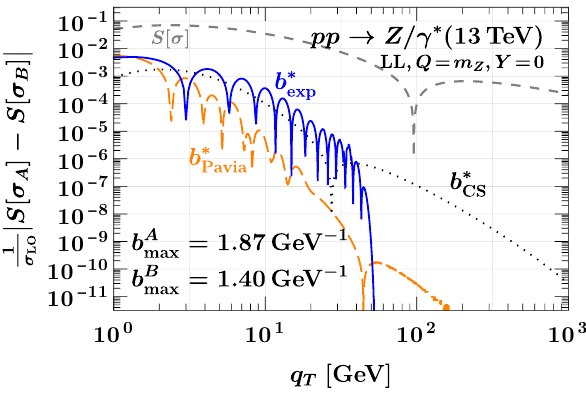
Figure 4 . Scaling of the ambiguity from the choice of b max for different b ∗